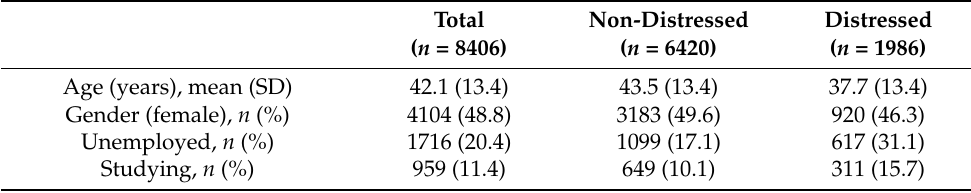
Table 1. Summary demographics of participants, by distressed and non-distressed group.